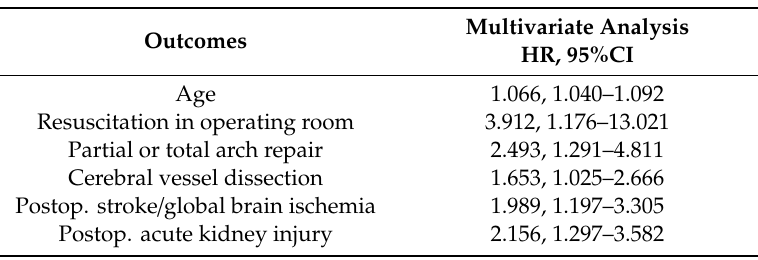
Table 3. Independent preoperative, operative and postoperative risk factors associated with poor late all-cause mortality after surgery for type A aortic dissection.